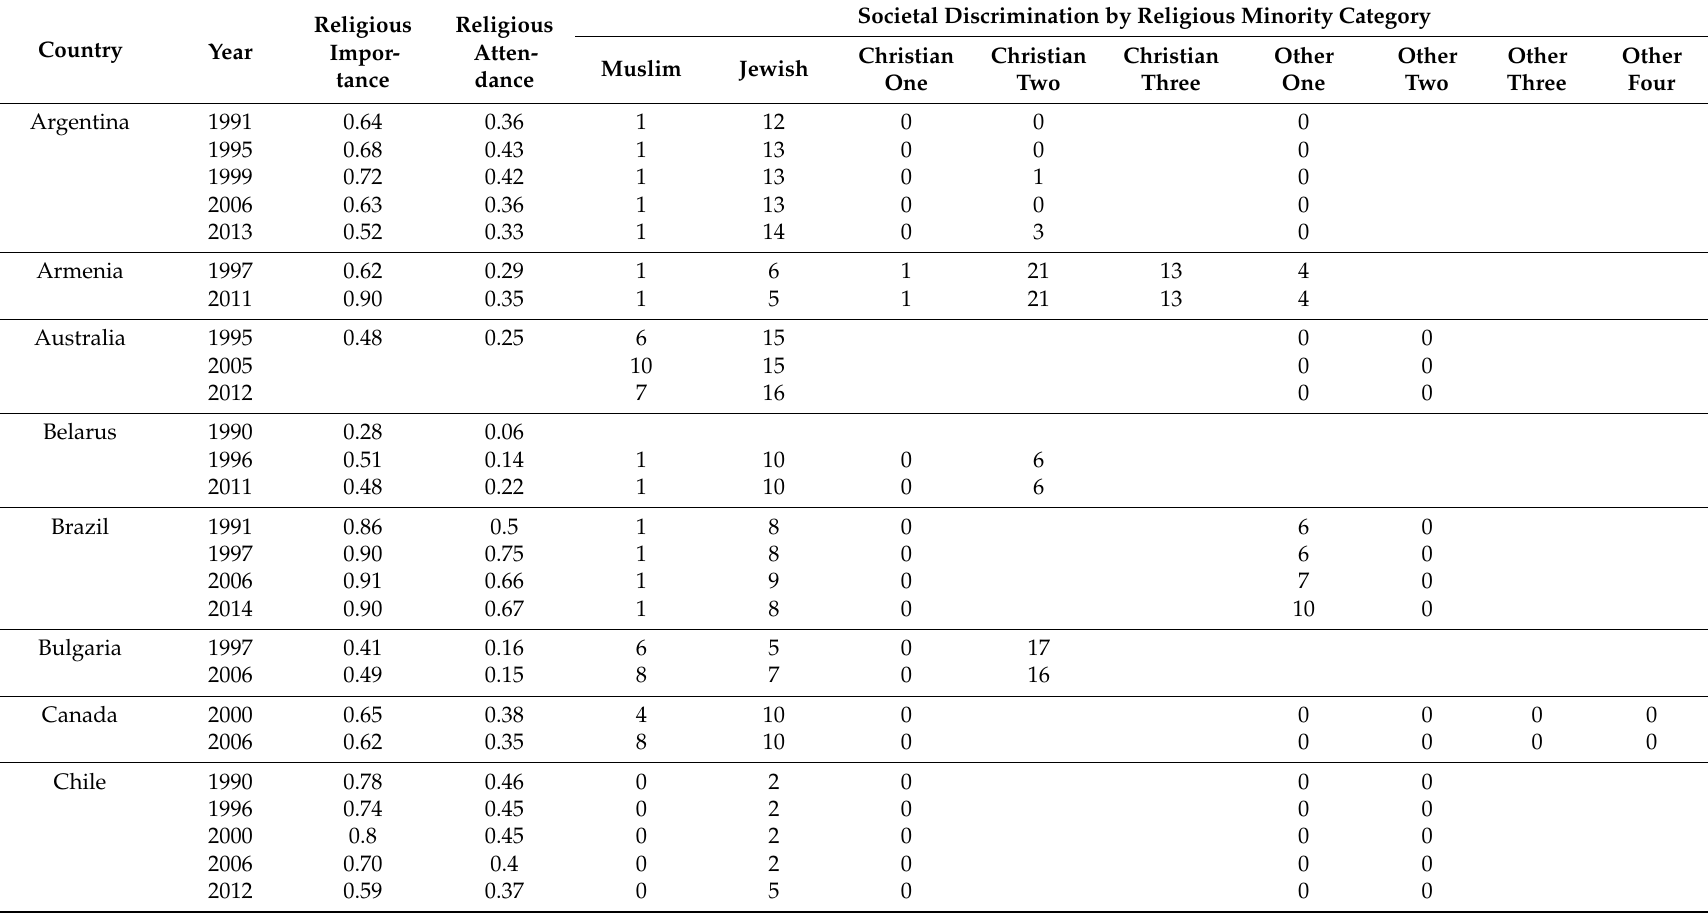
Table A1. Appendix of Countries, Years, Religiosity, and Societal Discrimination by Religious Minority